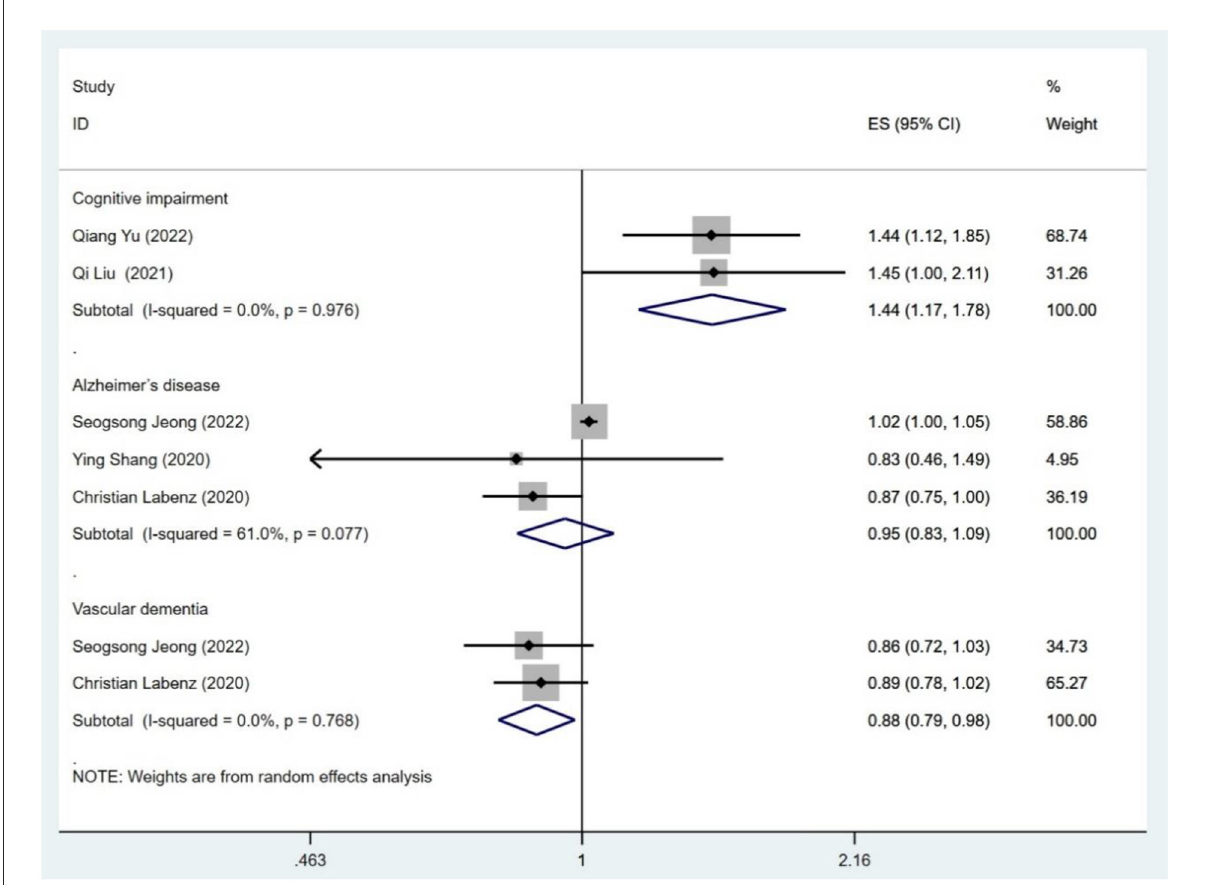
FIGURE2 Meta-analysis of the risk of cognitive impairment, Alzheimer’s disease and vascular dementia caused by